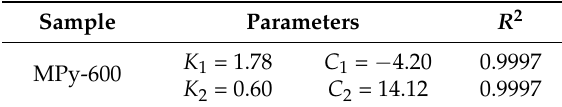
Table 4. Kinetic Parameters of the Weber-Morris Model.